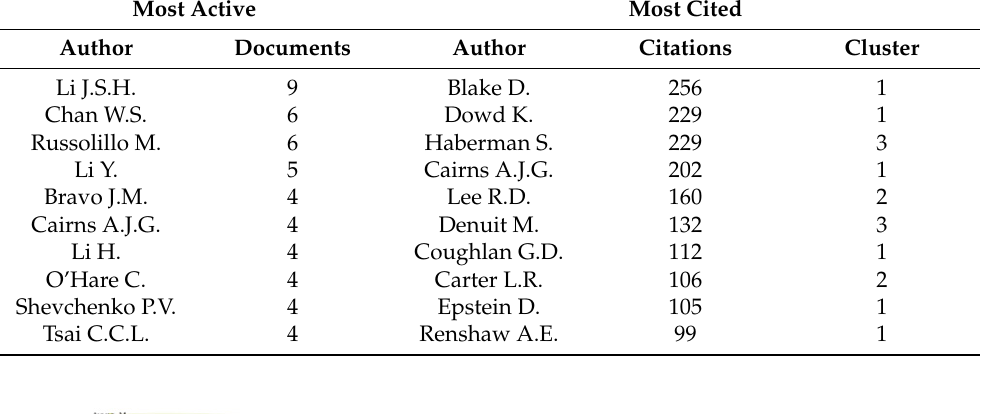
Table 2. Top 10 most active and most cited authors.